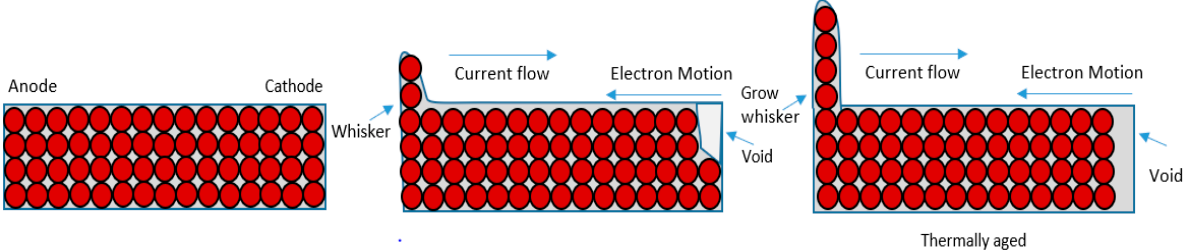
Figure 13. Schematic diagram of tin whisker growth under electromigration and thermal ageing.